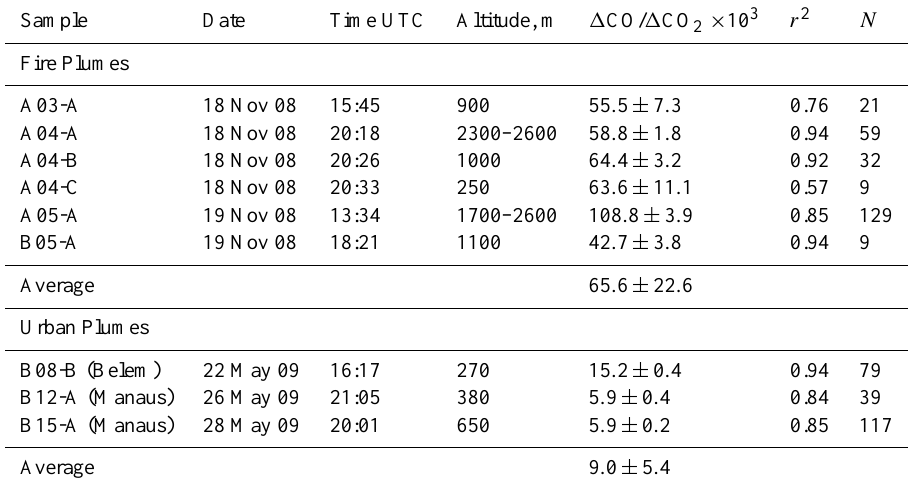
Table 1. Emission ratios 1 CO/ 1 CO 2 measured during the BARCA campaign flights.